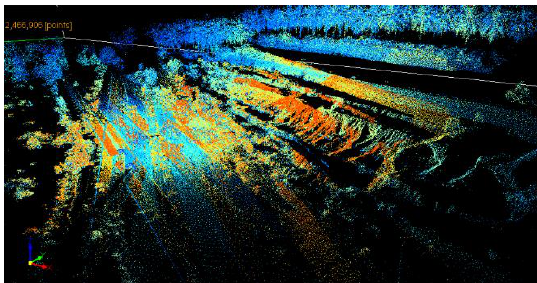
Figure 28. Data before registration was not aligned after the scan data was imported